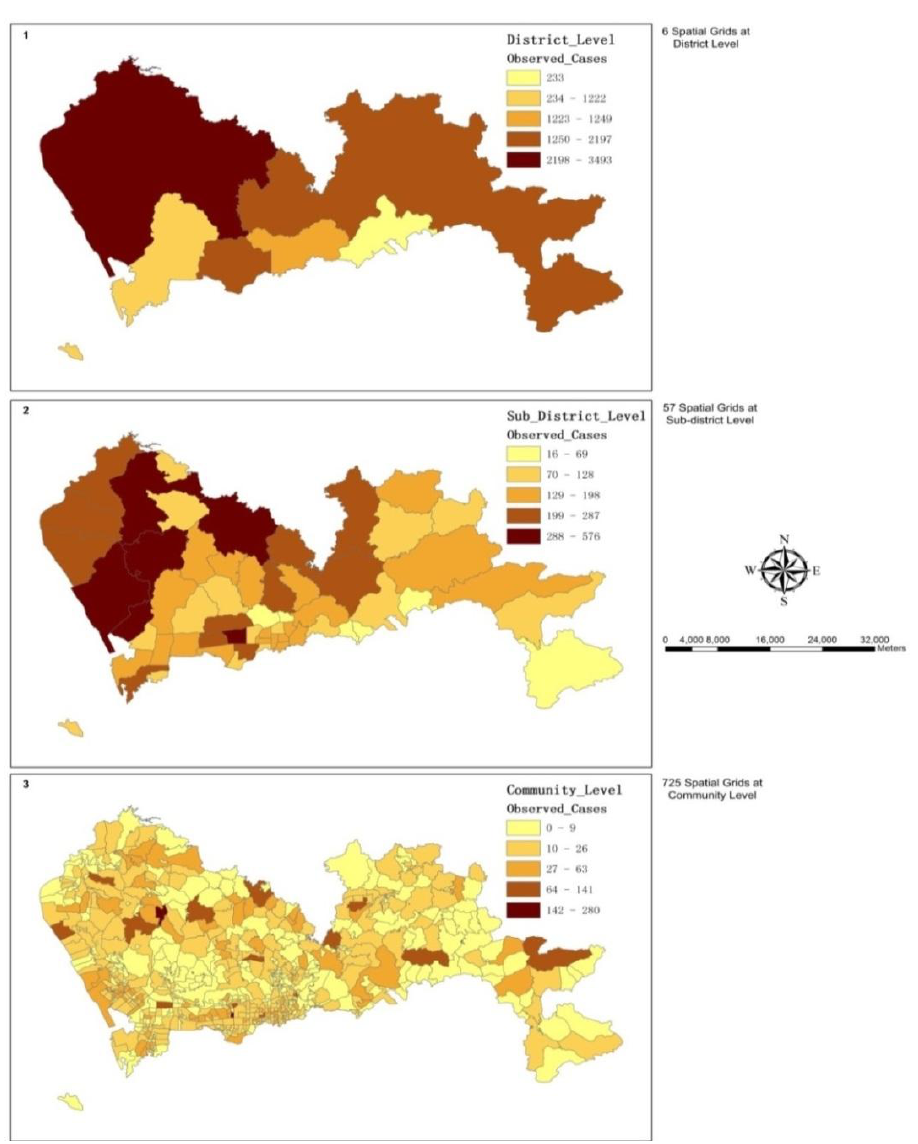
Figure 4. These maps illustrate the spatial variations of the observed hypertension admission cases at multiple levels: ( 1 ) the district level; ( 2 ) the sub-district level, and ( 3 ) the community